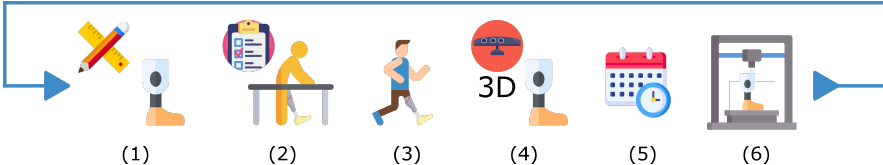
Figure 17. The traditional pipeline with the addition of technology integration. (1) Limb measure- ments and socket fabrication. (2) Check socket. (3) Provisional/Definitive socket. (4) Scan of current plaster cast mold. (5) 6–12 months before receiving a definitive socket. (6) 3D Re-fabrication of the mold from the digital